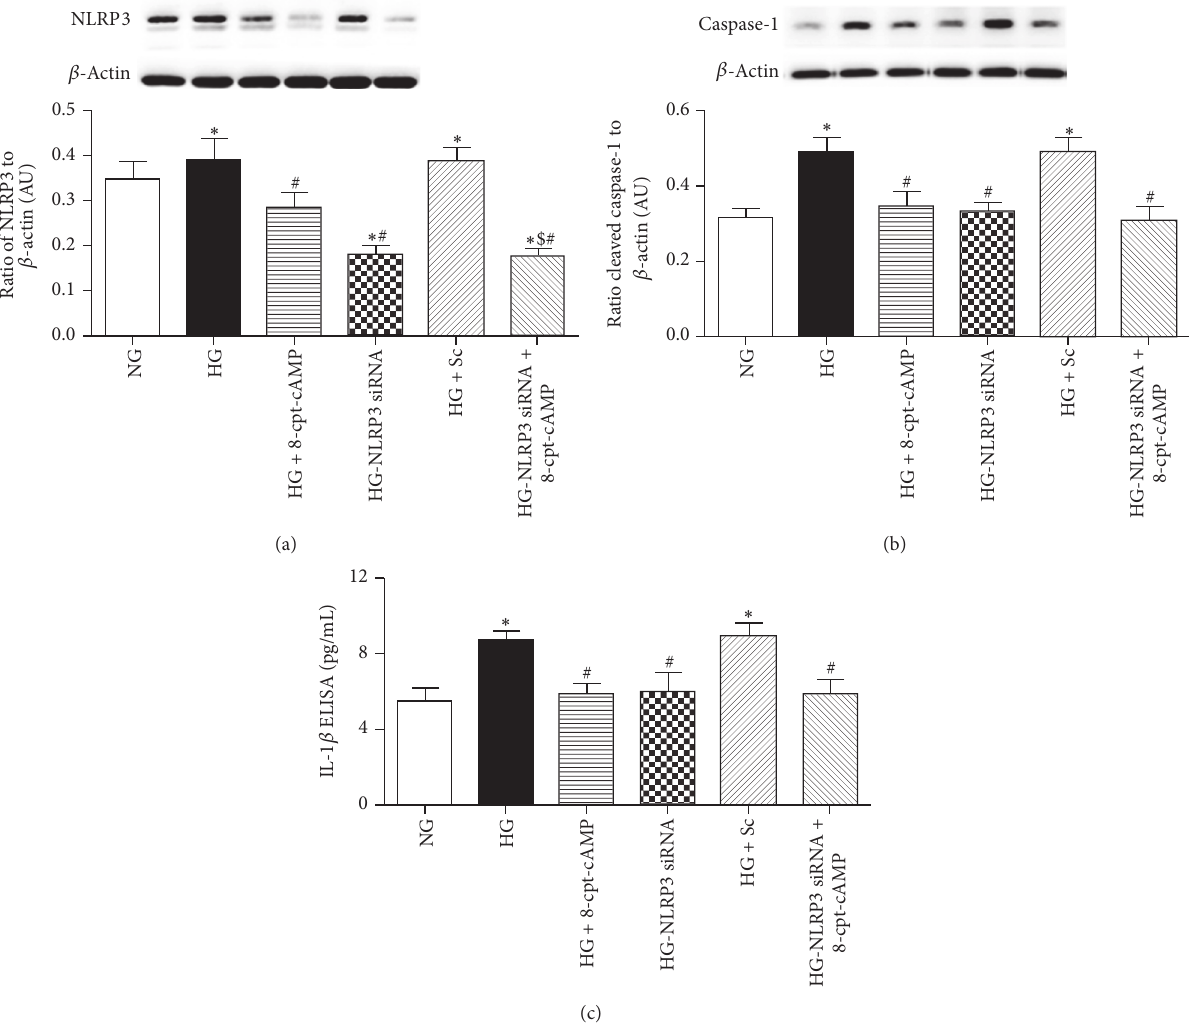
Figure 4: Epac1 and NLRP3 both can reduce cleavage of caspase-1 and IL-1 𝛽 . Protein analyses from REC grown in normal glucose (NG), high glucose (HG), high glucose + Epac1 agonist (HG + 8-cpt-cAMP), high glucose + NLPR3 siRNA (HG + NLRP3 siRNA), high glucose + scrambled siRNA (HG + Sc), and high glucose + Epac1 agonist + NLRP3 siRNA (HG + NLRP3 siRNA + 8-cpt-cAMP) for NLRP3 (a), cleaved caspase-1 (b), and IL-1 𝛽 (c). 𝑁 = 6 for NLRP3 and cleaved caspase-1; 𝑁 = 5 for ELISA for IL-1 𝛽 . Data are mean ± SEM. ∗ 𝑃 < 0.05 versus NG; # 𝑃 < 0.05 versus HG; $ 𝑃 < 0.05 versus